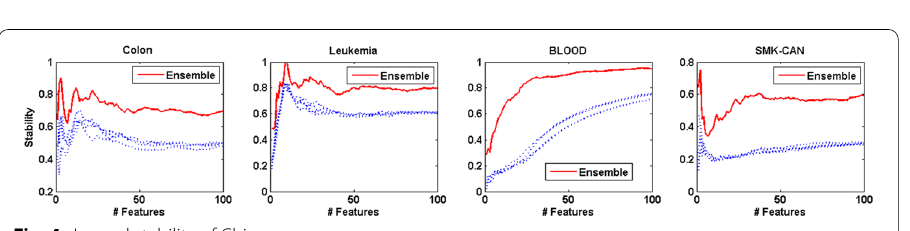
Fig. 4 Jaccard stability of Chi